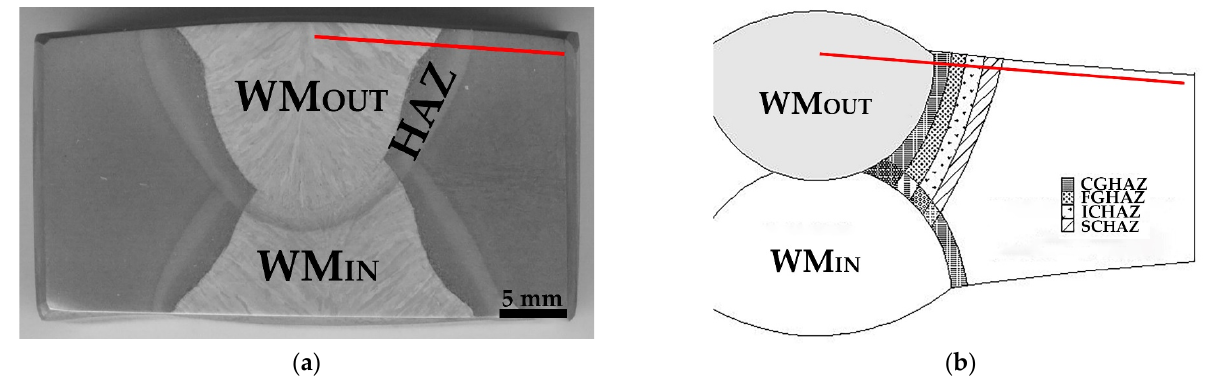
Figure 2. Macro morphology ( a ) and schematic diagram ( b ) of the welded joint and location marked by red line of hardness tests. The abbreviations in the figure are explained as follows: the heat- affected zone (HAZ), the outside welding (WM OUT ), the inside welding (WM IN ), the coarse grain heat-affected zone (CGHAZ), the fine grain HAZ (FGHAZ), the intercritical HAZ (ICHAZ) and the subcritical HAZ (SCHAZ).